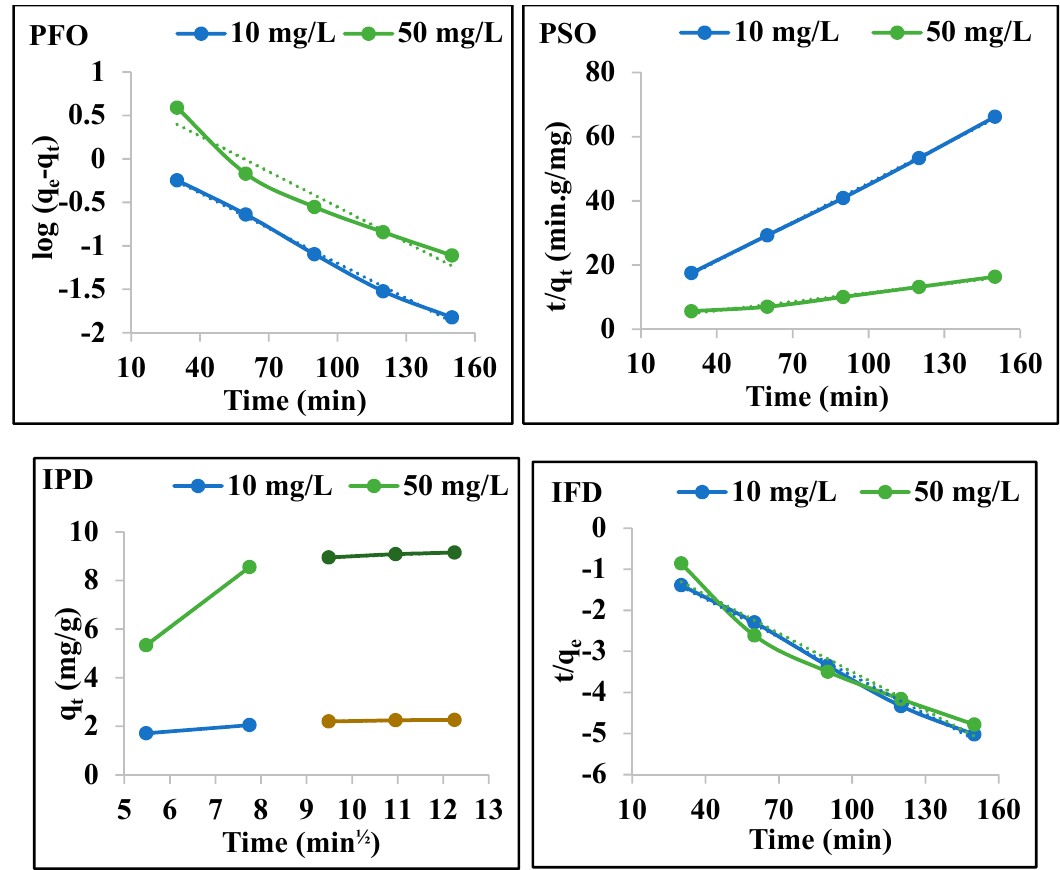
Figure 7. Four kinetic model plots (pseudo-first-order (PFO), pseudo-second-order (PSO), intraparticle diffusion (IPD), and liquid film diffusion (LFD)) for the adsorption of Cu 2+ by AgNPs (adsorbent dosage, 0.2 g; concentration of Cu 2+ , 10 and 50 mg/L at pH 7, and 298 K). Table 1. Parameters of four kinetic models.